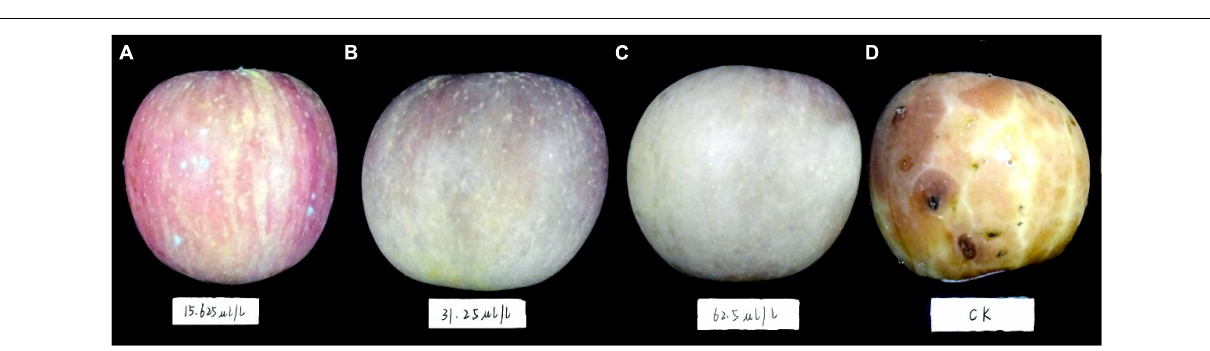
FIGURE 6 | The apple fruit was first dipped in a Botryosphaeria dothidea culture for 15 min, subsequently exposed to various concentrations of dimethyl trisulfide, then cultured at 28 ◦ C in the dark for 4 weeks. Apple fruits with different treatments exhibited varying degrees of disease symptoms. (A) 15.63 µ L/L, (B) 31.25 µ L/L, (C) 62.5 µ L/L, (D)